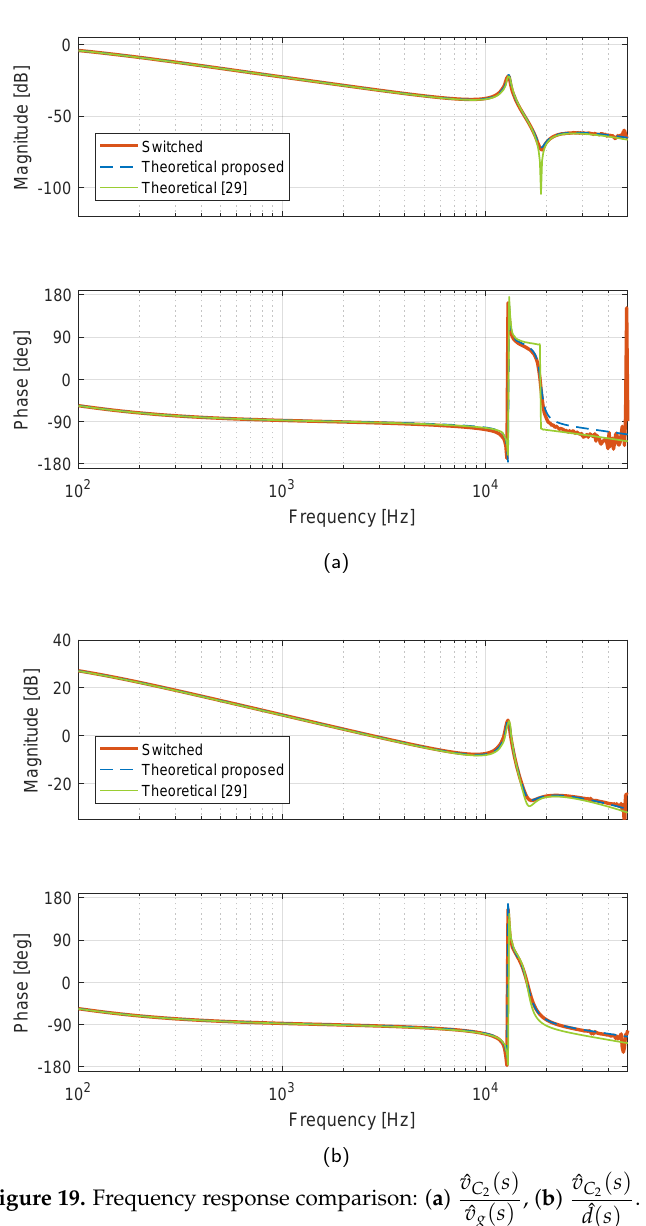
Figure 19. Frequency response comparison: ( a )